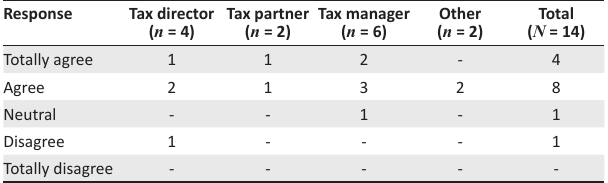
TABLE 6: Results of whether the term ‘anticipated’ is unclear.